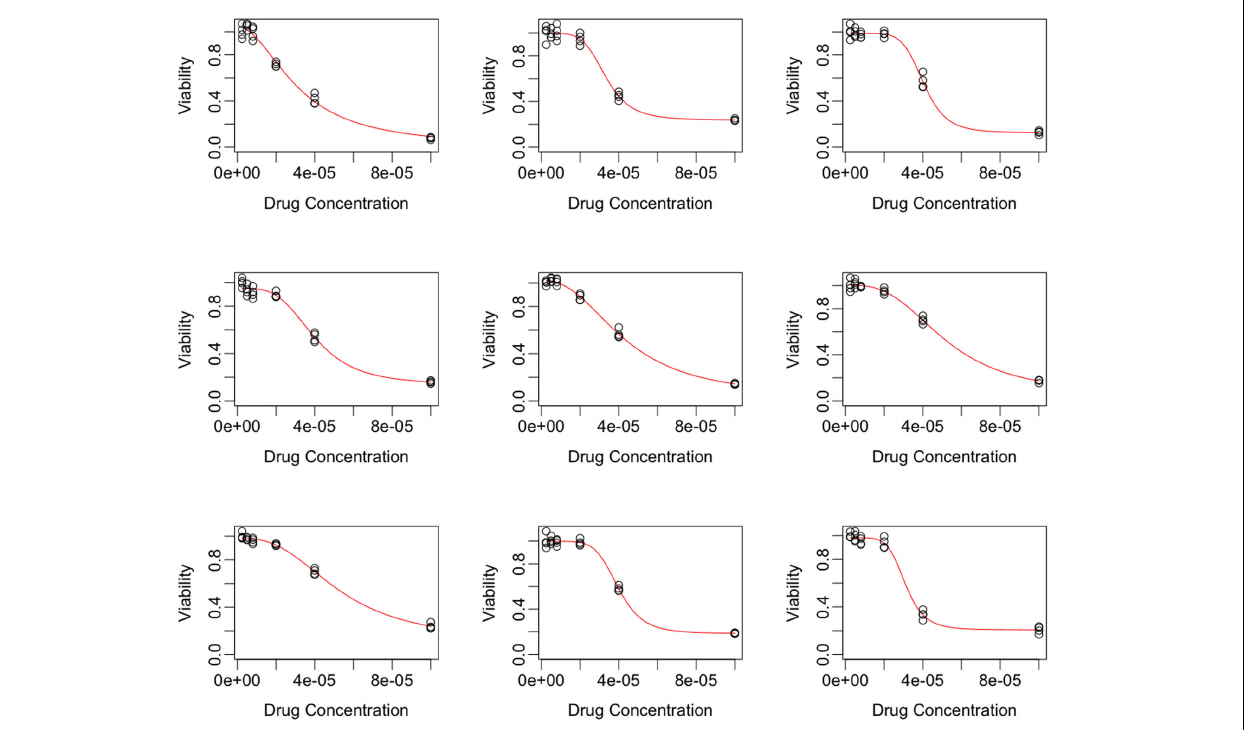
FIGURE 1 | Hill slope functions fit to real data from nine random Gemcitabine dose-response curves.